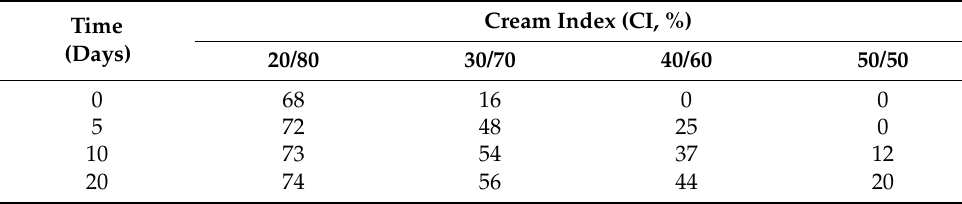
Table 1. Creaming index evolution along 20 days for the tested formulations (20/80, 30/70, 40/60, and